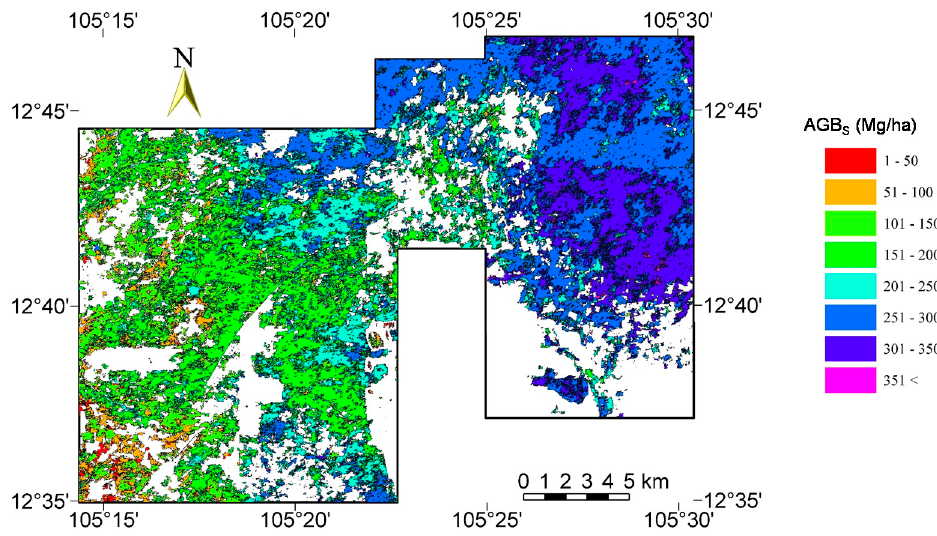
Figure 8. Map of the object-based AGB values from the model based on the satellite image data (AGB S ).